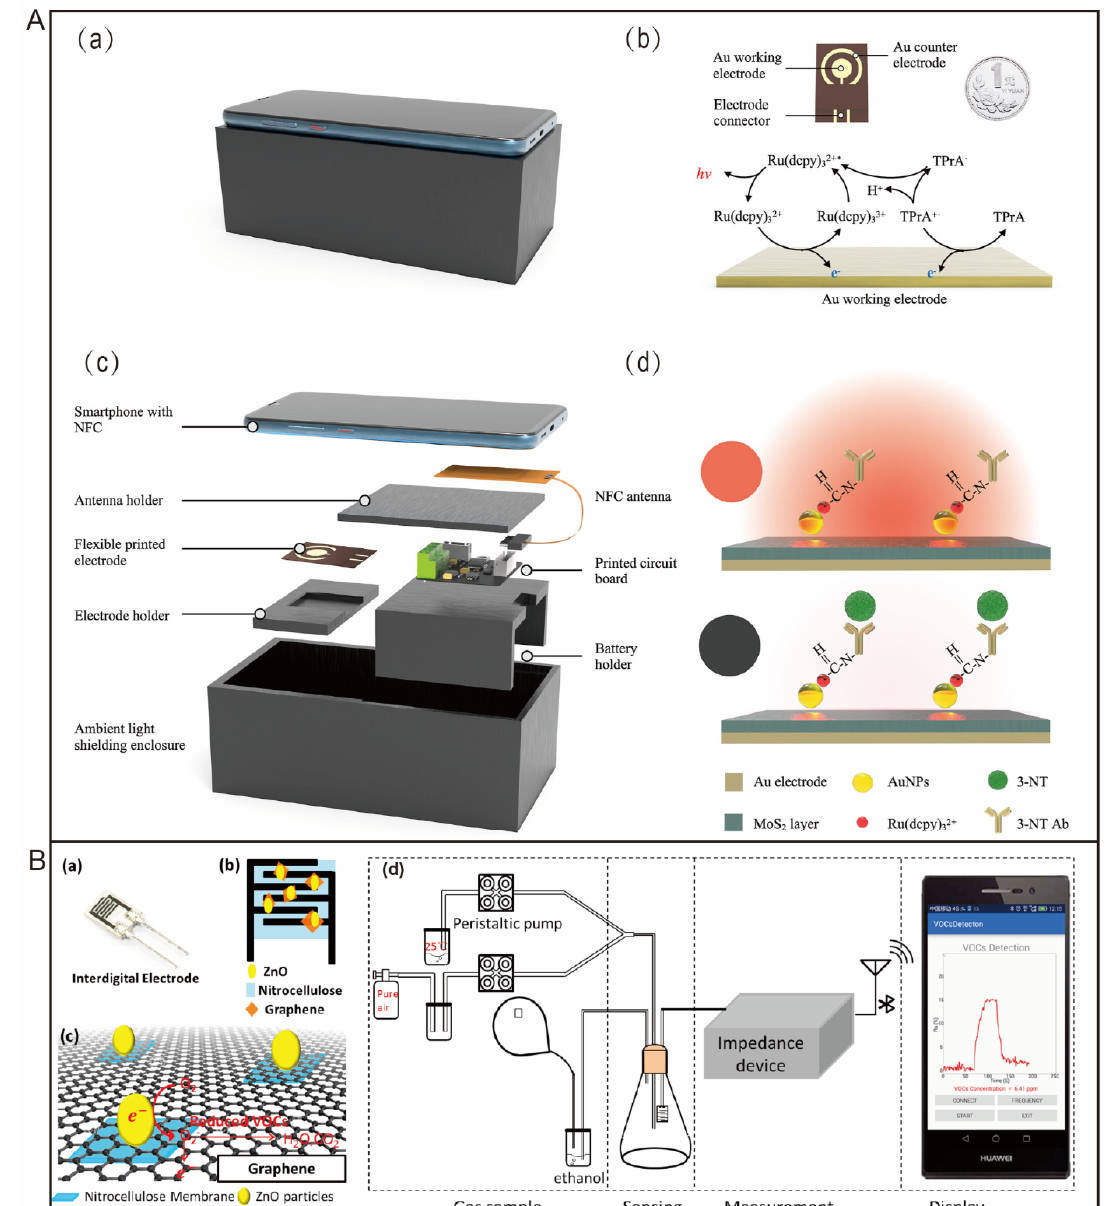
Figure 3. ( A ) Schematic diagram of smartphone-based ECL analysis device. ( a ) Three-dimensional (3D)-printing shell integrated with smartphone excluding ambient light. ( b ) Principle of Ru(dcpy)32+/TPrA-based ECL. ( c ) Details of the device in exploded view. ( d ) Diagram of ECL analysis for 3-nitrotyrosine detection. ( B ) Schematic diagram of smartphone-based sensor for VOC de- tection. ( a ) Photo of the interdigital electrodes. ( b ) Electrodes modified by graphene, ZnO, and nitro- cellulose membrane. ( c ) Mechanism for detection of VOCs on the modified electrodes. ( d ) Schematic diagram of detecting procedures, including gas sample, sensing, measurement, and display on a smartphone.